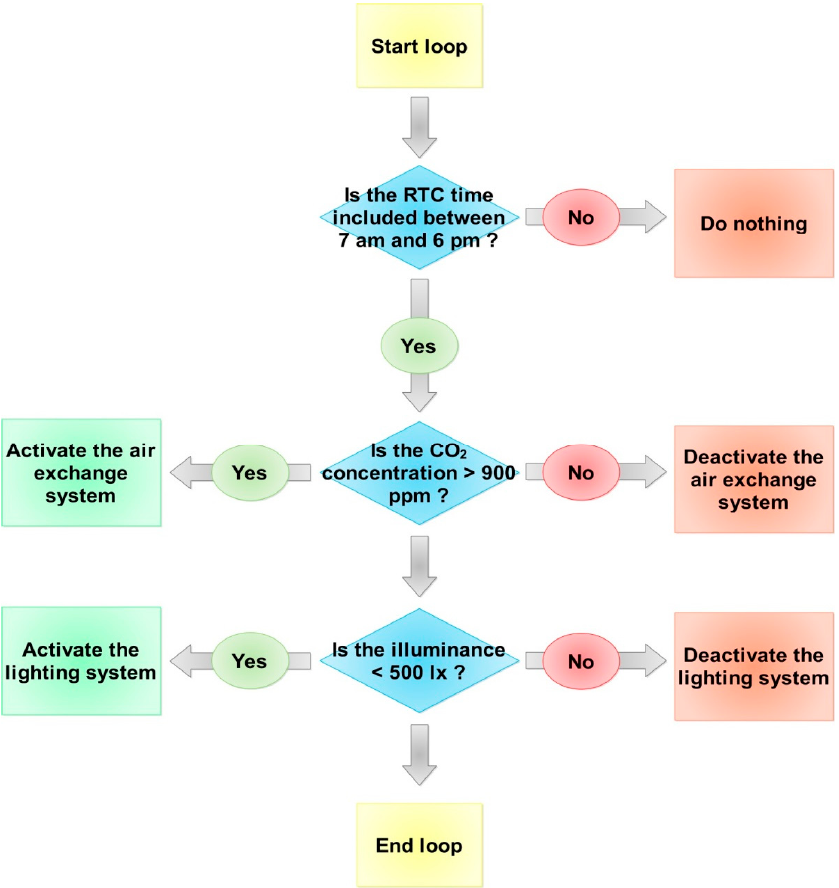
Figure 5. Flow chart of the control logic.